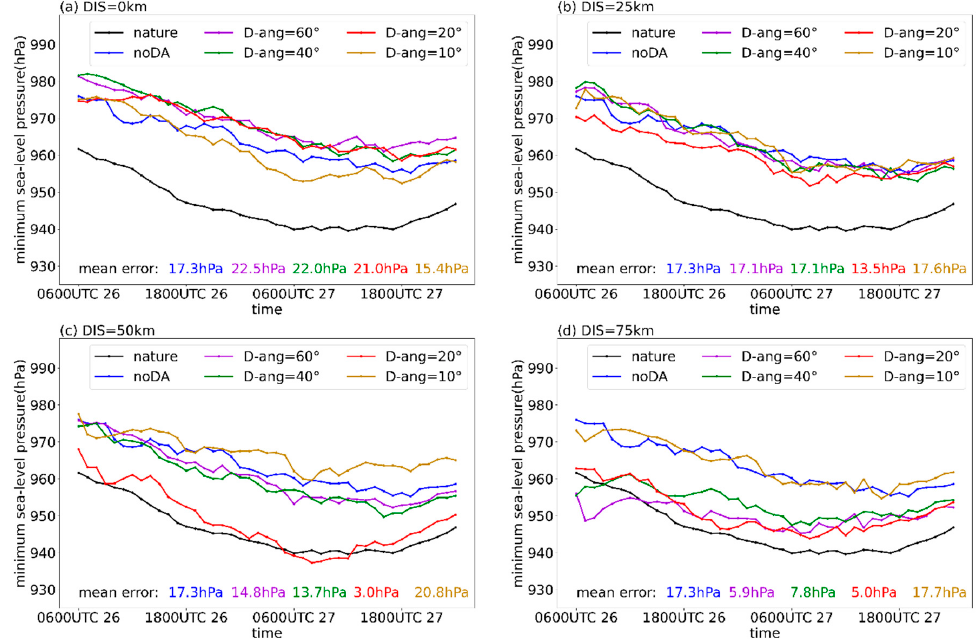
Figure 10. The minimum sea-level pressure of TC forecast when DIS equals ( a ) 0, ( b ) 25 km, ( c ) 50 km, and ( d ) 75 km. The intensity forecast under various D-angs is shown by different colors. The mean absolute intensity error during simulating period of each experiment is noted in the figure with the corresponding color.